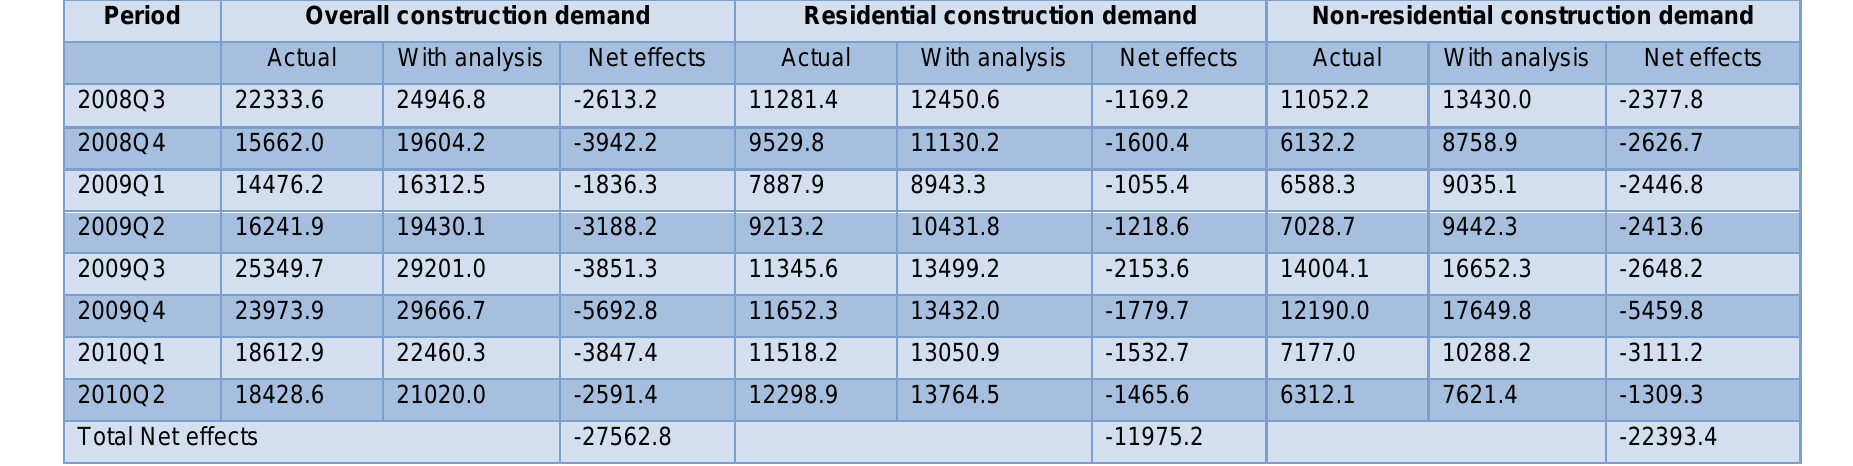
Table 4 Results of the impact of the late 2000s global financial crisis on the construction demand (Scenario B) Note: the duration of the intervention period is from 2008Q3 to